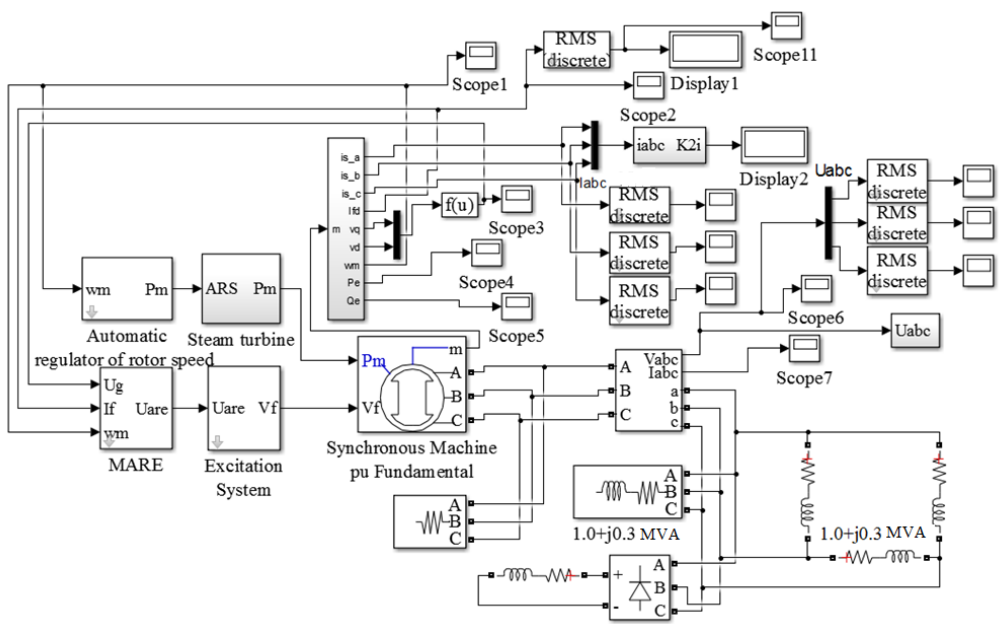
Figure 19. Flow chart of a computer model of the turbogenerator serving an unbalanced and non- linear load.